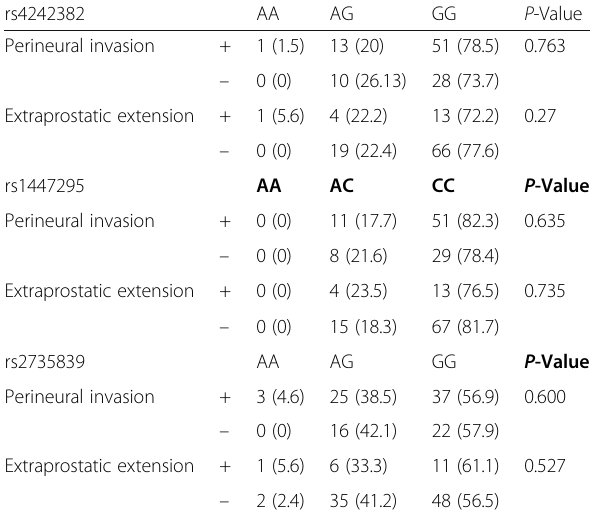
Table 7 Genotype distribution of polymorphisms and p -value in mentioned clinical features